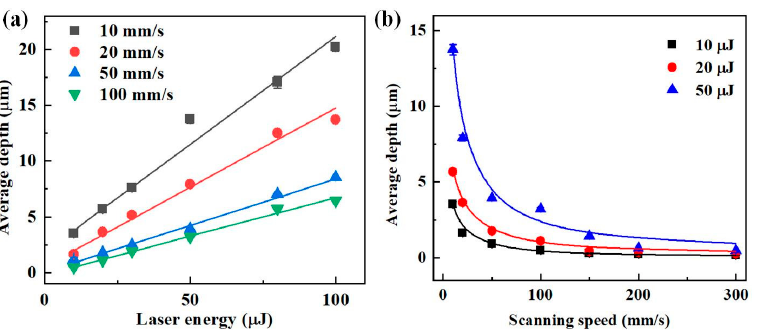
Figure 10. E ff ects of parameters on average depth. ( a ) The average depth is a function of laser energy. ( b ) The average depth is a function of the scanning speed.